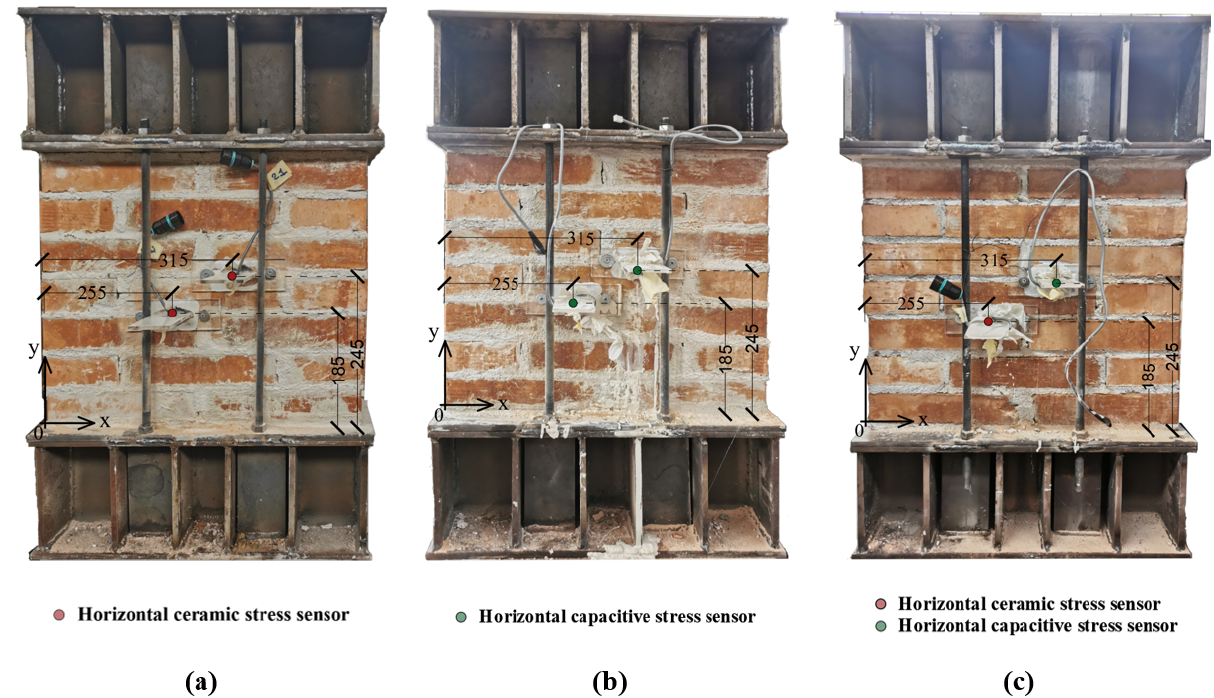
Figure 7. Sensor placement (dimensions in mm) for post-installation system P2: ( a ) pattern with two horizontal ceramic sensors; ( b ) pattern with two horizontal capacitive stress sensors; ( c ) pattern with two horizontal stress sensors, i.e., one ceramic and the other